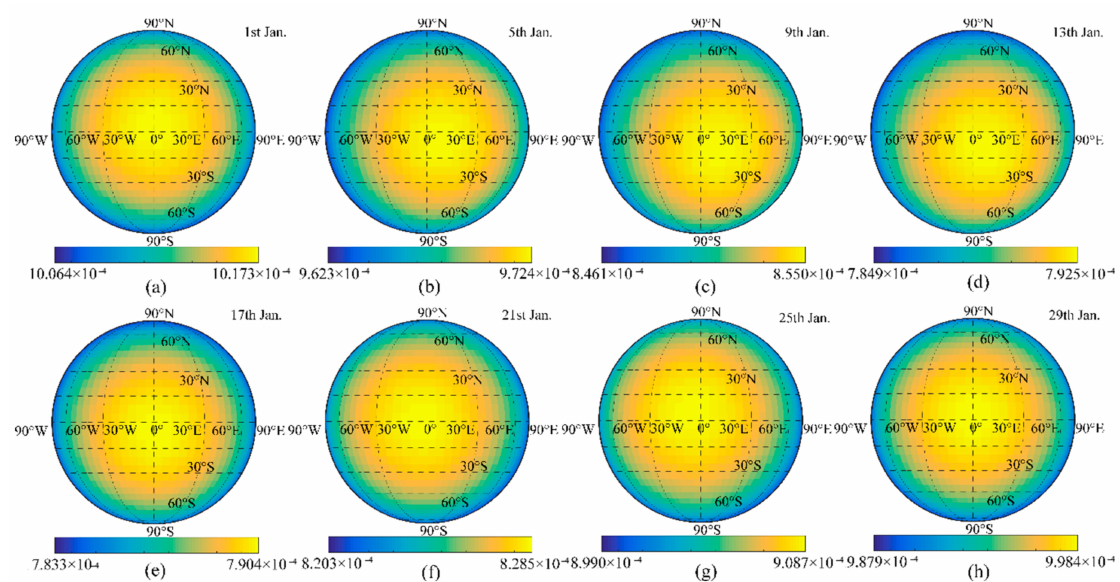
Figure 11. Distribution of the geometric factor (sr) on the near-side of the Moon during one orbital period; ( a – h ) represent the distribution for January 2020, with a four-day